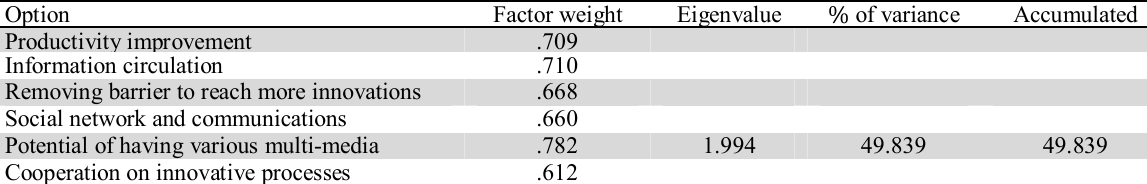
The summary of factors influencing human resource management Option Factor